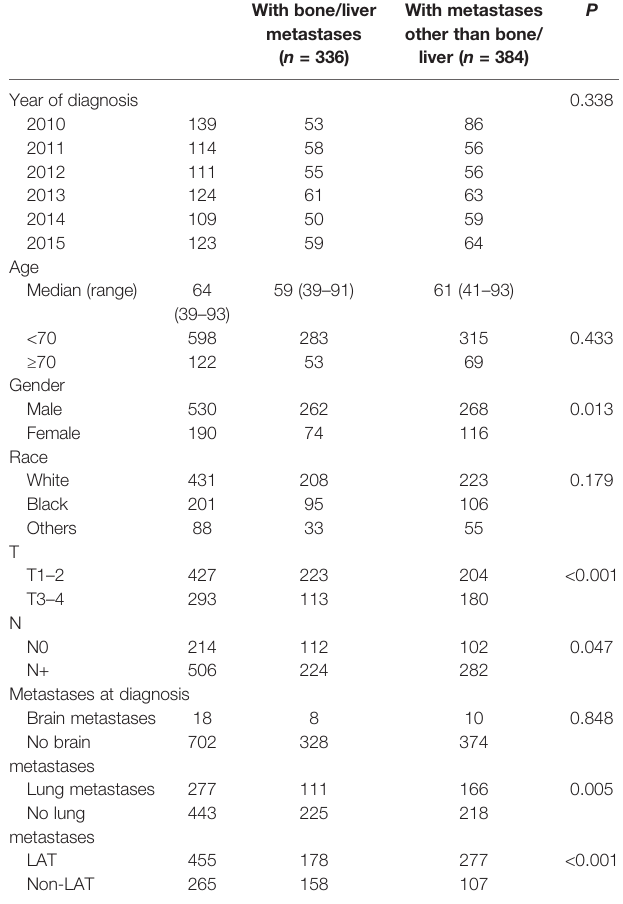
Survival Outcomes in Patients With Different Metastases To clarify the different role of LAT in patients with different metastatic sites, we further made a PSM according to age, gender, race, T stage, and N stage between the groups “ with bone/liver metastases ” and “ with metastases other than bone/liver ” . After PSM, data from 594 patients were available for analysis, and characteristics including age, gender, race, T stage, N stage, brain metastases, and lung metastases ( p > 0.05 for all) were well balanced between the two groups ( Table 4 ). For the 297 patients with bone/liver metastases, the median OS was 6.0 months (95% CI: 5.1 – 6.9 months), and the LAT and non-LAT groups had no signi fi cant difference ( p = 0.903) ( Figure 2B ). Patients with metastases other than bone/liver had a better median OS of 9.0 months (95% CI: 8.0 – 10.0 months), and patients with LAT improved median OS from 8.0 months to 10.0 months compared with non-LAT patients